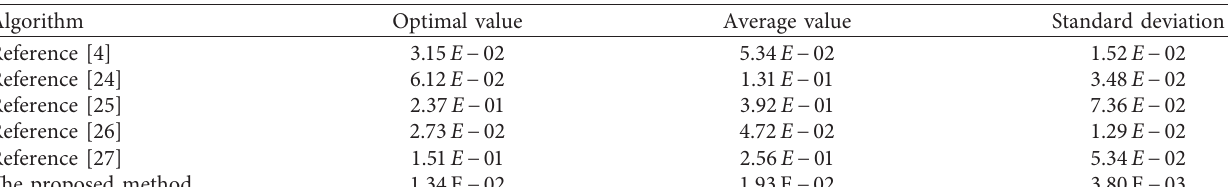
Figure 4: NBBO-based Iris classification diagram. Table 7: Simulation results of iris classification.